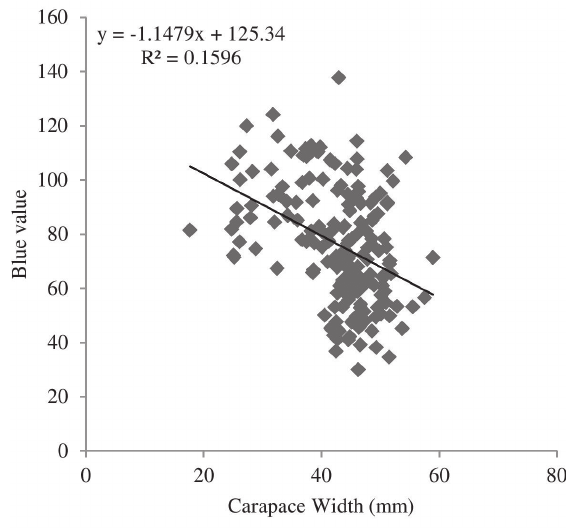
Figure 6 - Relationship between abdomen color values with size of females of Charybdis hellerii . ( F DF=1, P <0.0001; the other color spectra showed no statistical difference). Alpha value after Bonferroni correction P=